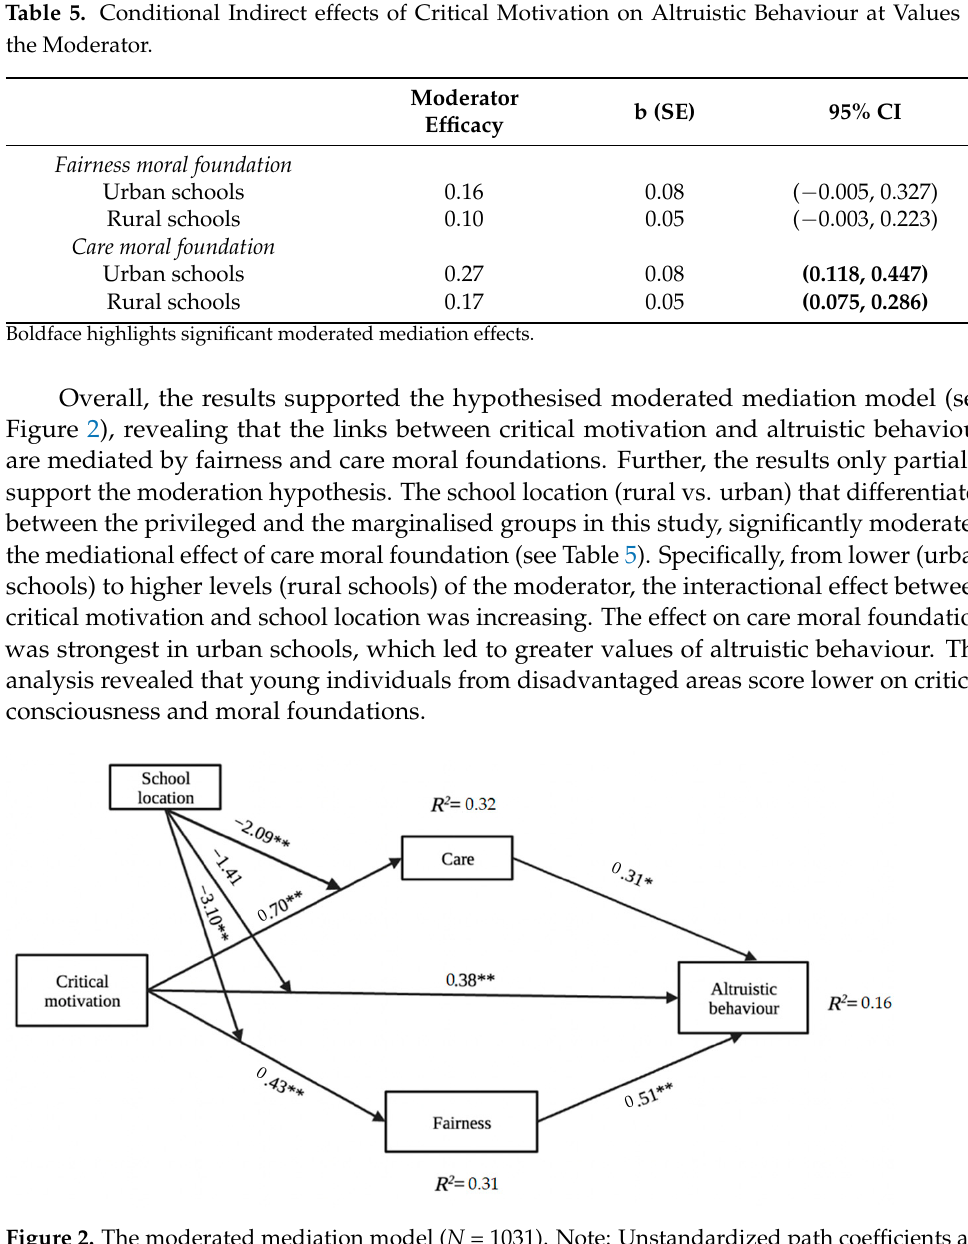
Figure 2. The moderated mediation model ( N = 1031). Note: Unstandardized path coefficients are reported. * p < 0.01; ** p < 0.001.